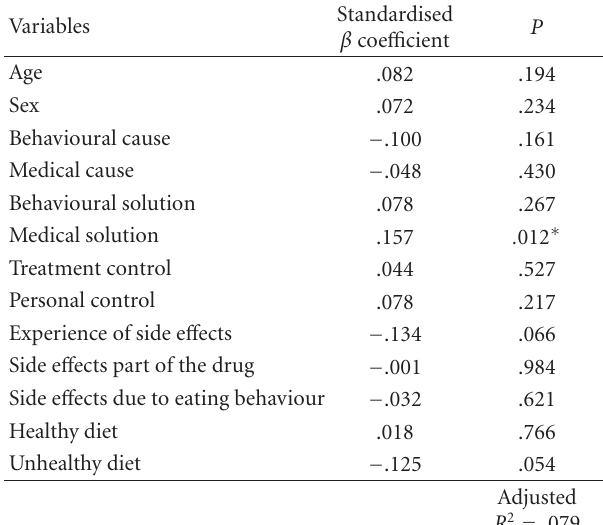
Table 3: Baseline predictors of a decrease in BMI over 6 months.